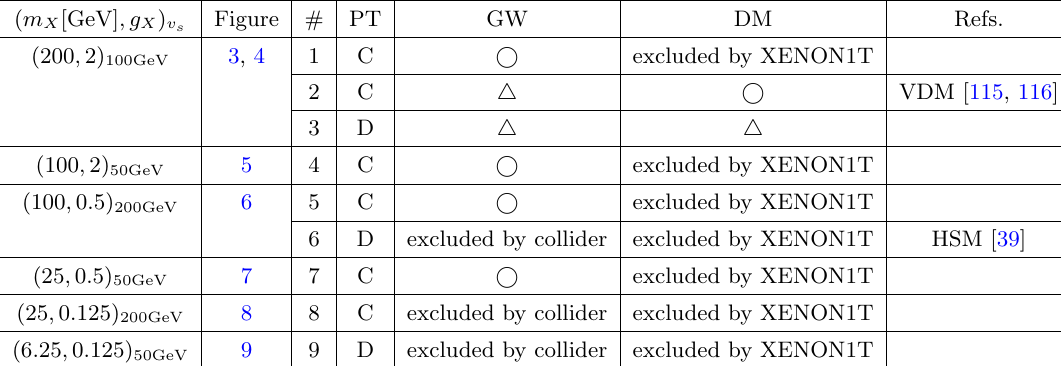
Table 2 . Summary of our numerical results. For each benchmark points, the types of the multi- step PT are listed and the different solutions in terms of the detectability of the GW observations and the DM constraints are labeled. In the GW column, which reach to the planned sensitivity of LISA and DECIGO. In the DM column for Model B, ( ) denotes that the VDM and nucleon elastic scattering cross section rescaled with relic density △ satisfy the bound from XENON1T [141] with the predicted relic density which accommodates the observed one (a subdominant DM